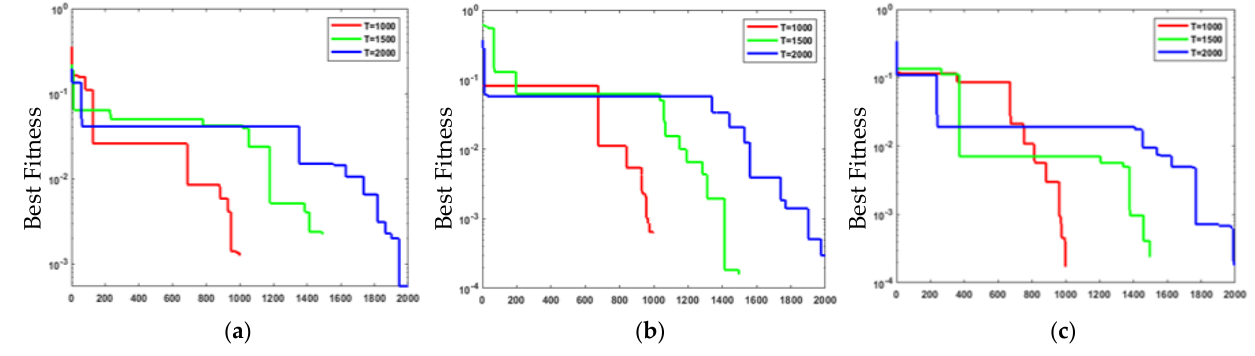
Figure 4. Fitness plots for AO with respect to generations. ( a ) Np = 30. ( b ) Np = 40. ( c ) Np = 50.